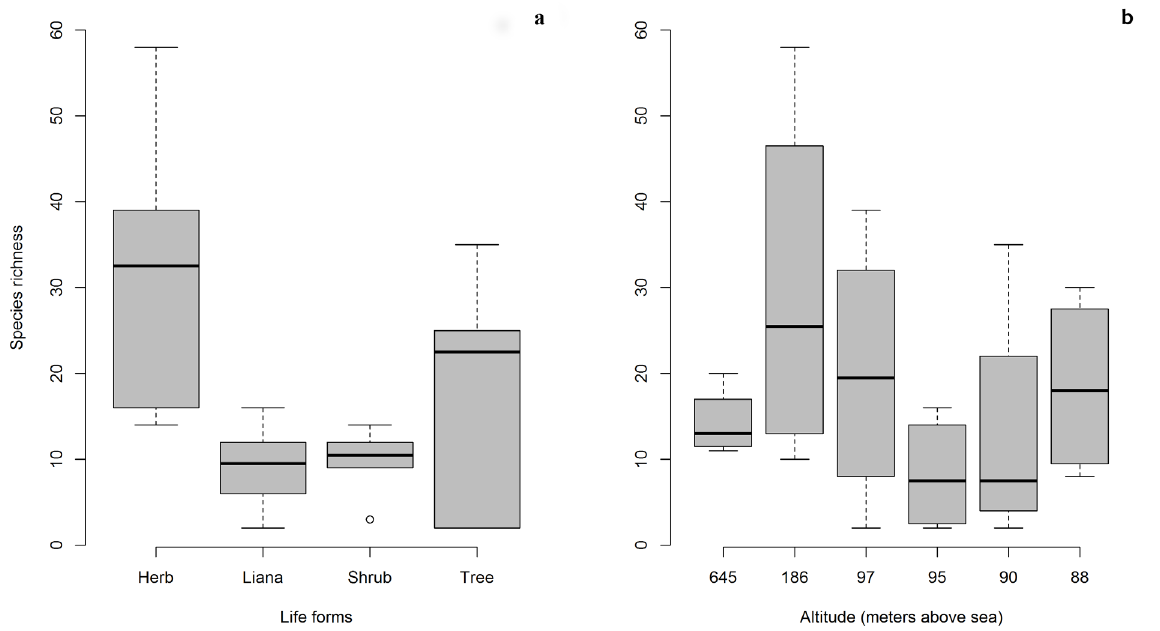
Figure 2 - Comparison of species richness in the sampled areas along the Paraguay River, Pantanal, Brazil. a - species richness per growth habit; b - species richness for each sampled environment (number of areas is available in Table